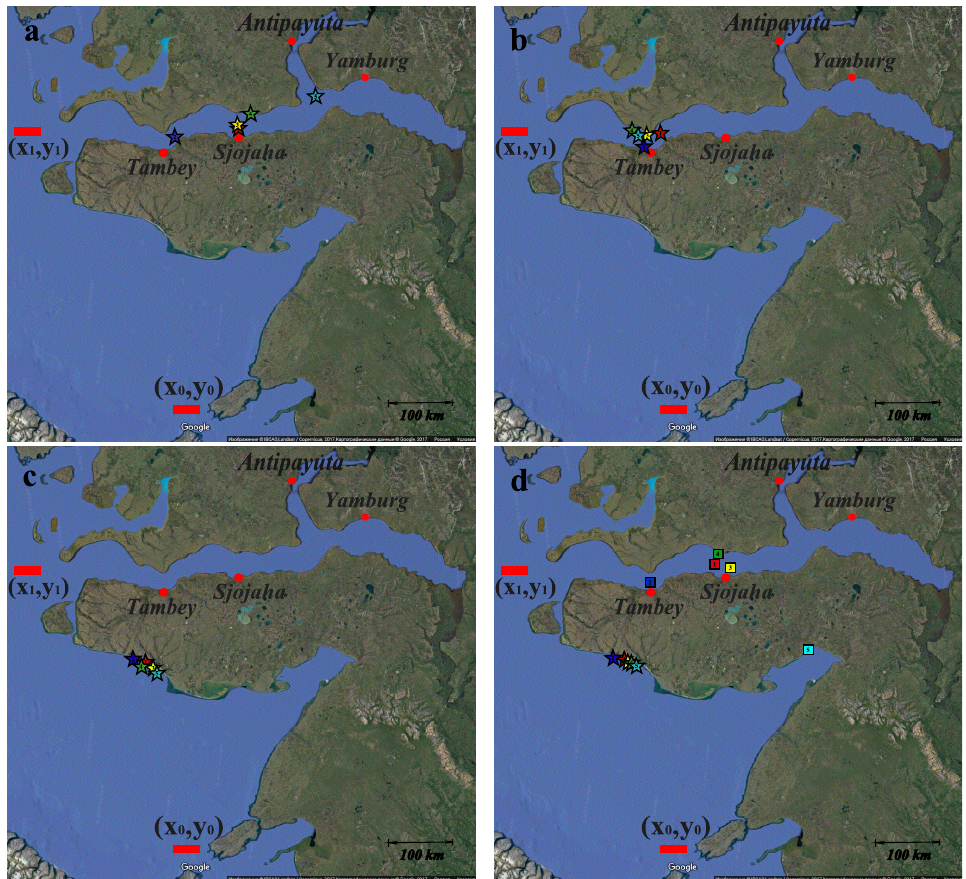
Figure 6. Economically optimal geographical places for unloading the vessel by helicopter are presented. The calculation corresponds to the cases presented in Table 1 for a mass of the transported cargo m = 24 tons: red star—1, blue star—2, yellow asterisk—3, green asterisk—4, blue asterisk—5 cases (similarly represented for mass m = 120 tons and denoted by squares, figure d). ( a ) calculation for F = 0 USD/h, ( b ) calculation for F = 3300 USD/h; ( c ) calculation for F = 6600 USD/h; ( d ) calculation for F (cid:29) 1000